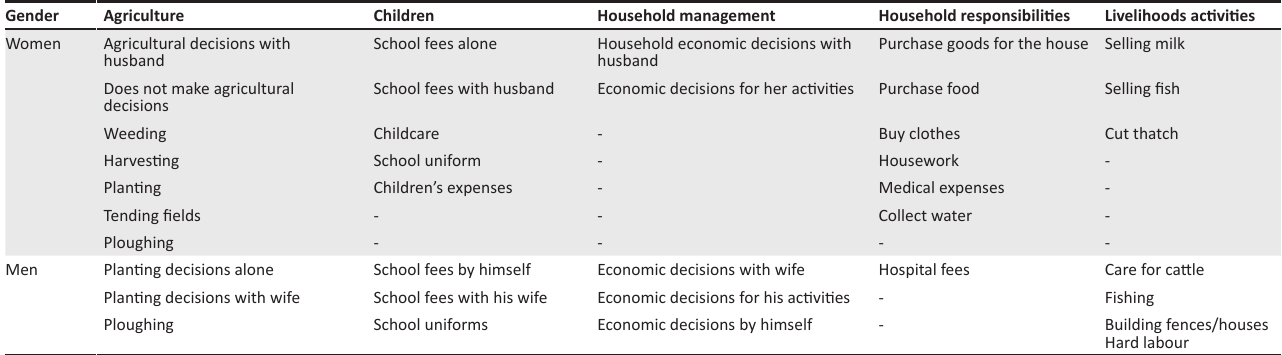
TABLE 2: Gender roles and responsibilities referenced by residents of Kasaya in